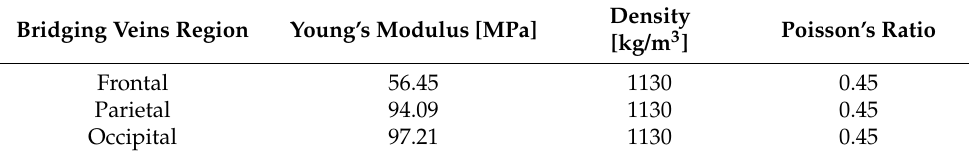
Table 2. Mechanical properties of bridging veins (samples from people older than 50 years of age [67]).